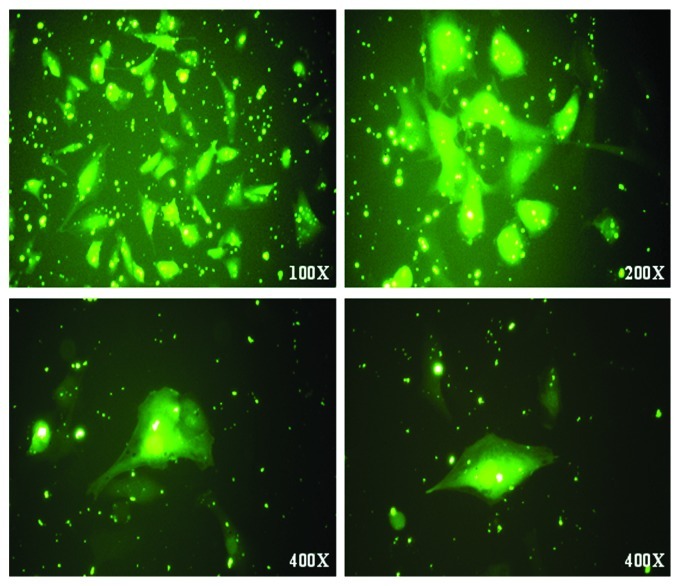
Transfection efficiency of siRNA of FTC-133 cells. Approximately 60% of whole cells were transfected with fluorescein-labeled siRNA (upper left panel, x100 magnification; upper right panel, x200 magnification). A ginkgo biloba formed single transfected cell and a spindle-shaped cell are shown in the lower panels (x400 magnification).